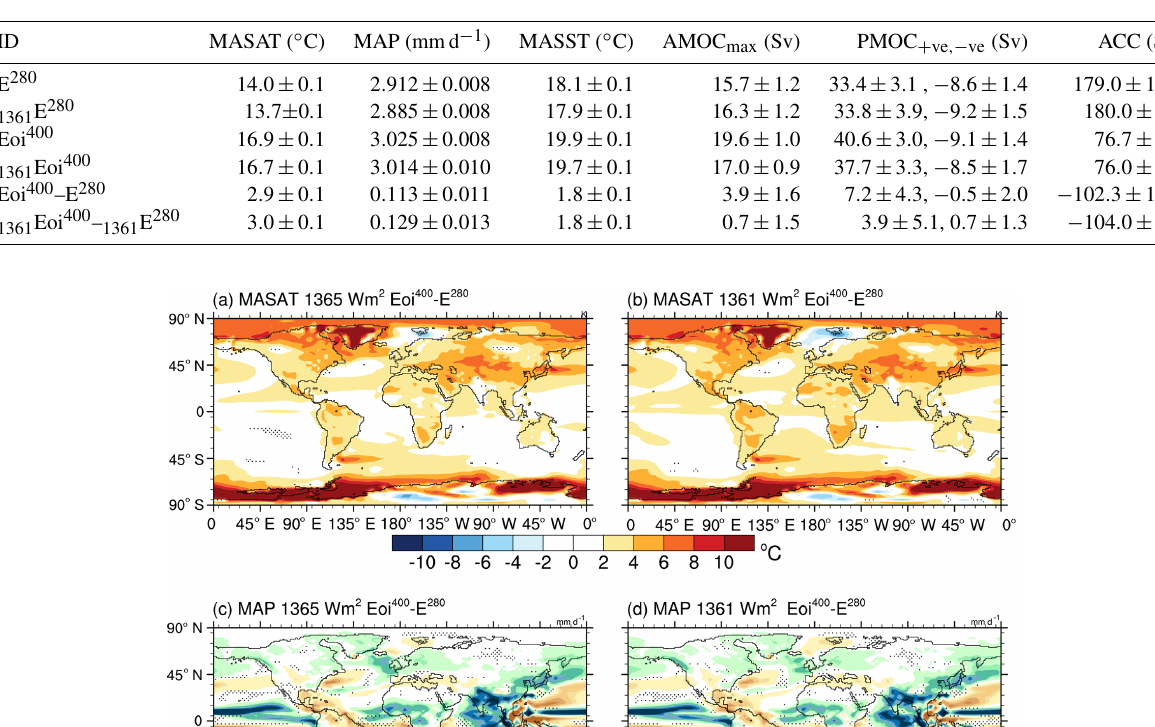
Table 9. Sensitivity of E 280 and Eoi 400 (and their corresponding anomalies) to TSI of 1361 and 1365Wm − 2 . Shown are the mean annual surface air temperature (MASAT), mean annual precipitation (MAP), mean annual sea surface temperature (MASST), Atlantic and Pacific meridional circulations (AMOC max and PMOC + ve , − ve ; Sect. 4.2.4) and Antarctic Circumpolar Current (ACC; Sect. 4.2.5).